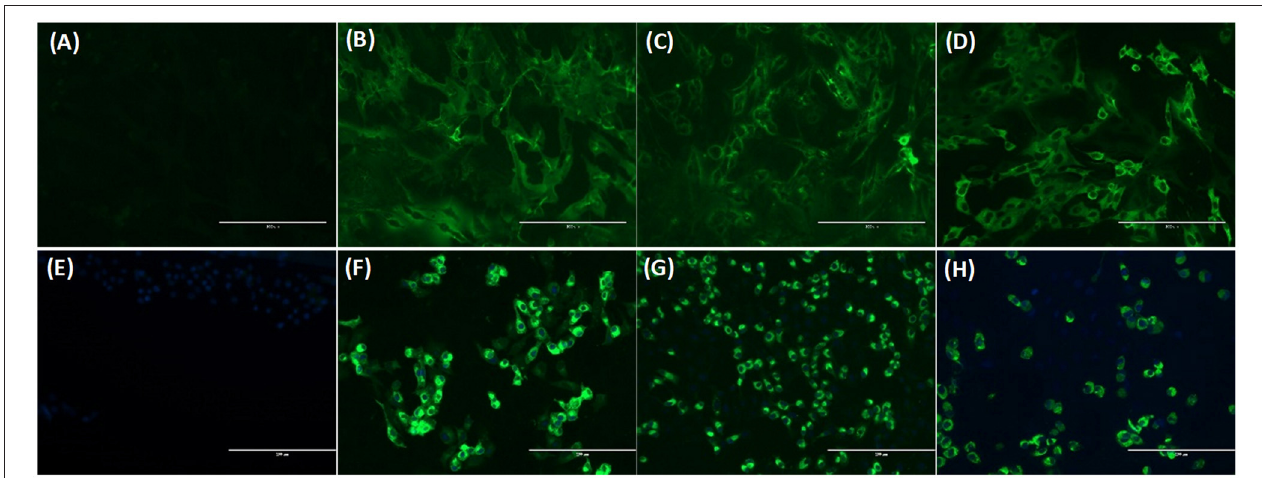
TABLE 6 | Cross-reactivity of FeCoV-specific antibodies with SARS-CoV-2. Cat ID RBD M N M N E VN IFA (SARS-CoV-2) IFA (FeCoV) FeCoV pos #1 0.21 Neg 2.17 Pos 2.86 Pos FeCoV pos #2 0.15 Neg 1.29 FeCoV pos #0 0.18 FeCoV pos #3 0.09 Neg 0.2 0.28 FeCoV pos #4 0.11 FeCoV pos #5 0.31 Neg 0.26 FeCoV pos #6 0.12 Neg 0.19 FeCoV pos #7 0.05 Neg 0.15 FeCoV pos #8 0.07 Neg 0.15 Neg 0.12 Neg FeCoV pos #27 0.09 Neg 2.63 FeCoV pos #28 0.28 Neg 2.03 Pos 2.41 FeCoV pos #29 0.07 Neg 0.97 FeCoV pos #30 0.22 Neg FeCoV neg #9 0.23 Neg 0.09 Neg 0.55 FeCoV neg #10 0.07 Neg FeCoV neg #11 0.27